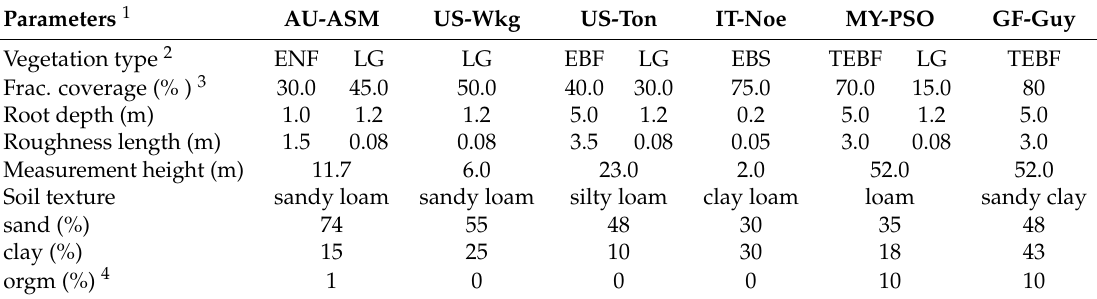
Table 3. Parameters for SVS and CLASS models at each FLUXNET site used in this